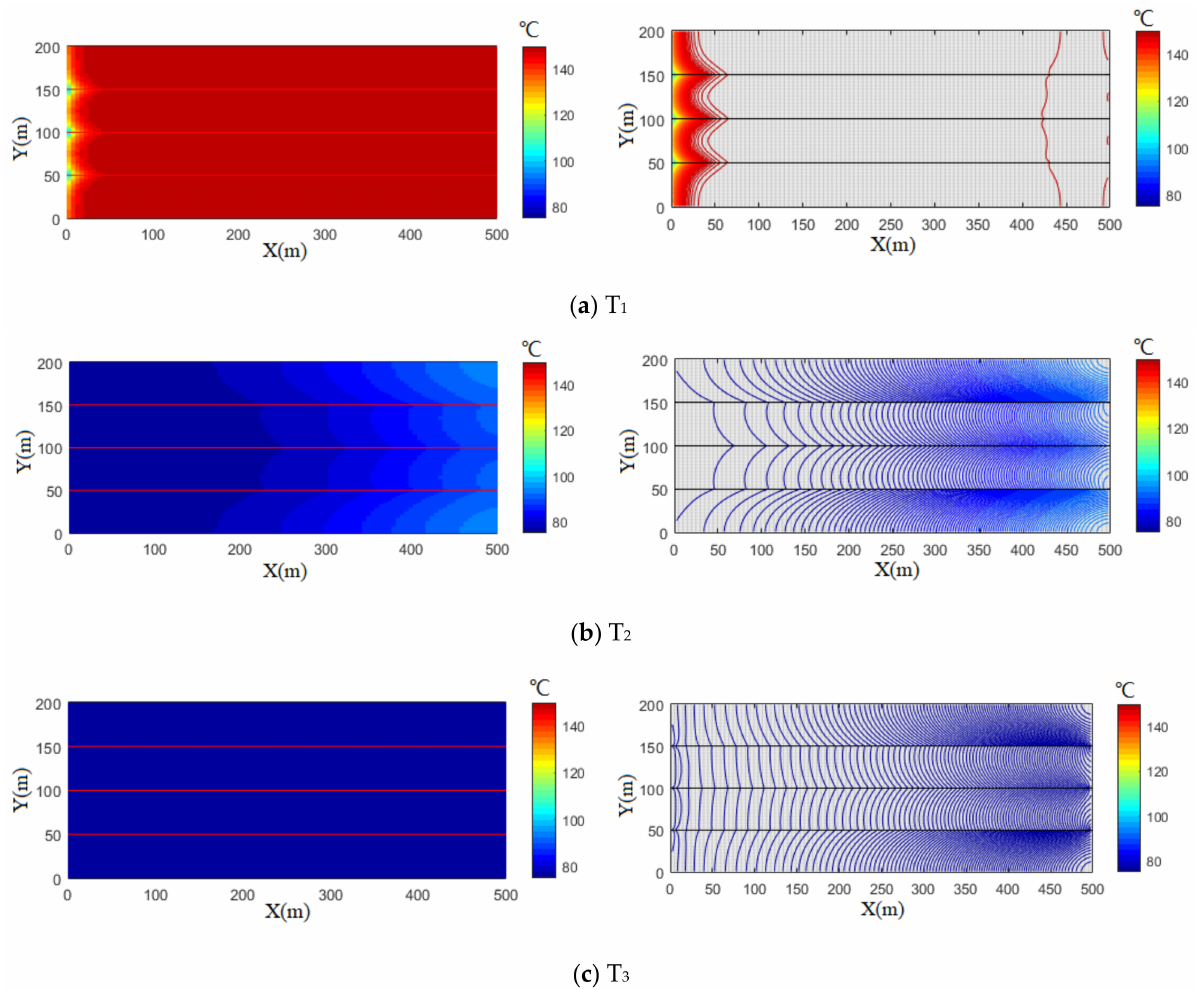
Figure 3. The temperature distribution marked by color (pictures on the left side) and contour (pictures on the right side) at different times (T 3 > T 2 > T 1 ). Compared with ( a – c ), the temperature falls off firstly in the fractures and the temperature difference between fractures and matrix becomes less with the time advancing. Finally, the temperature in matrix approaches the injection temperature.